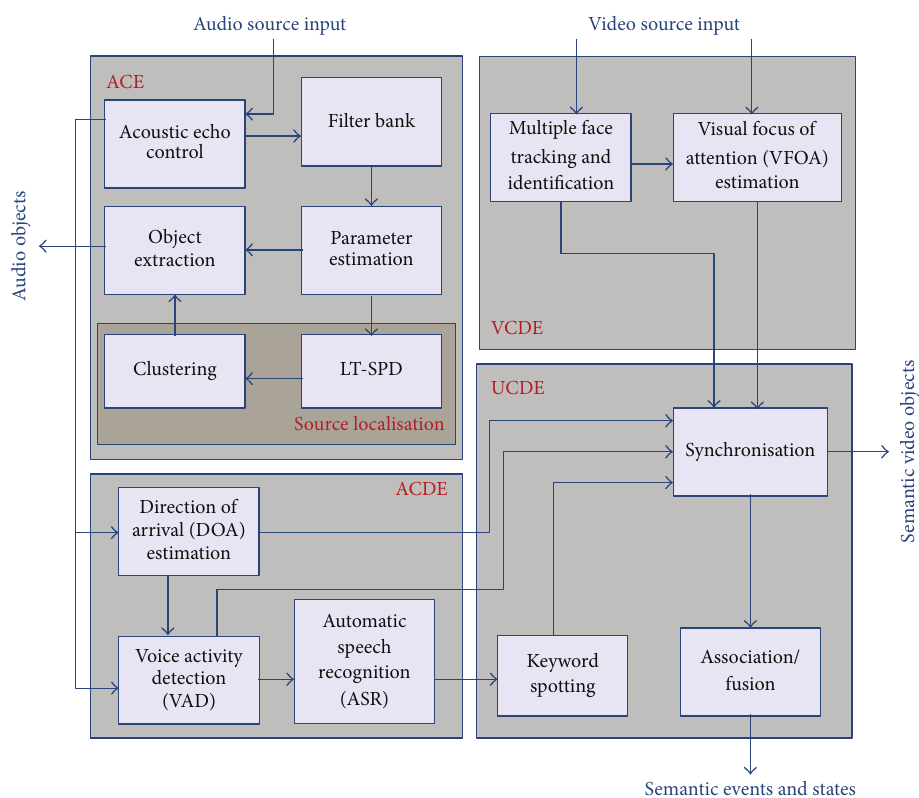
Figure 2: Block diagram of the intelligent audio capturing and semantic information extraction modules. The components are grouped into four parts: audio communication engine (ACE), audio cue detection engine (ACDE), video cue detection engine (VCDE), and unified cue detection engine